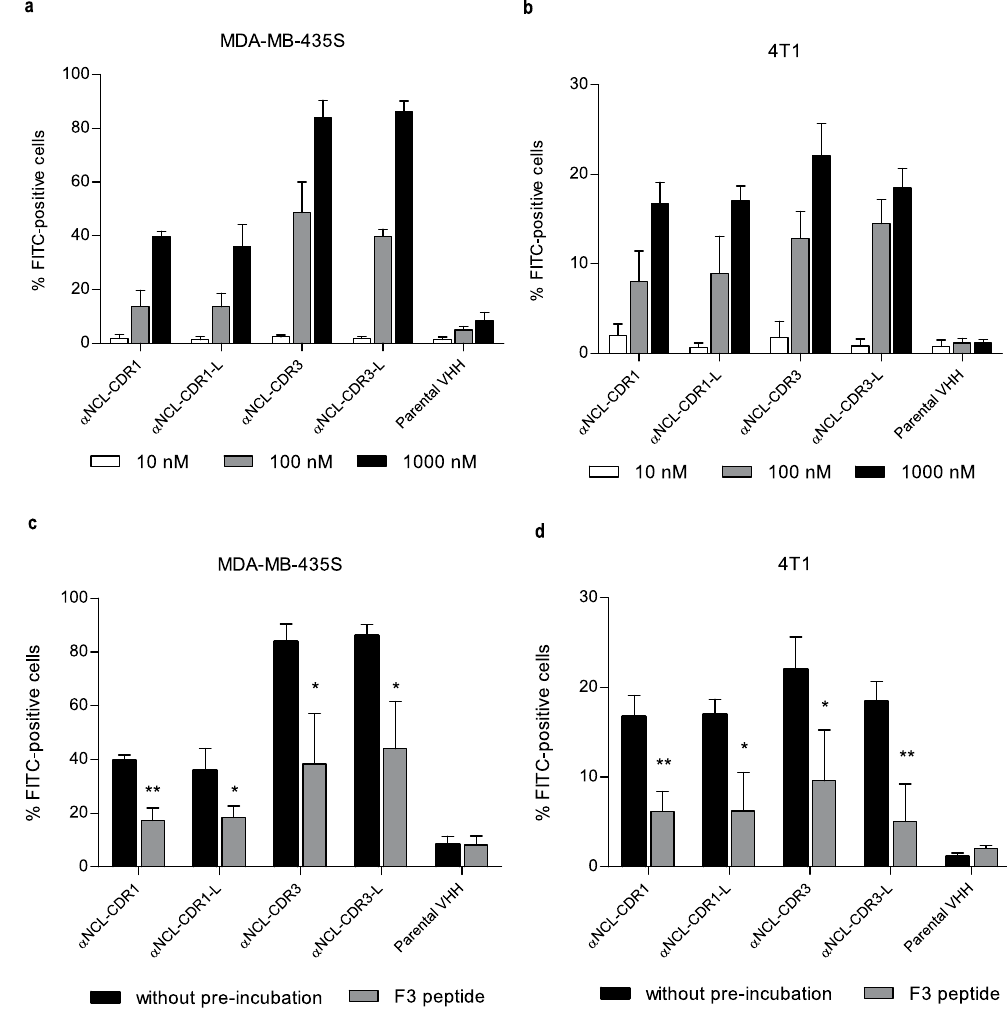
Figure 2. Binding of different VHH constructs to nucleolin-overexpressing cells. One hundred thousand of MDA-MB-435S ( a , c ) or 4T1 ( b , c ) cells were incubated with parental VHH or VHHs grafted with a nucleolin- binding peptide sequence either onto CDR1 or CDR3, with ( α NCL-CDR1-L or α NCL-CDR3-L, respectively) or without ( α NCL-CDR1 or α NCL-CDR3, respectively) flanking linkers at the end of the grafted CDR, for 45 min at 4 °C. Binding was assessed with a final incubation with anti-HA-FITC antibody and further analysis by flow cytometry. Competitive inhibition assays were also performed for each cell line ( c , d ), upon pre- incubation of the cells with 75 µ M F3 peptide (gray bars), for 30 min at 4 °C. A control without competitive inhibition was performed (black bars). Data represent the mean ± SD of three independent experiments, performed in duplicate. Differences in binding among the VHHs tested were evaluated by one-way ANOVA followed by Tukey’s test. Differences in binding, with or without pre-incubation with F3 peptide, were evaluated by Student’s t-test ( * p < 0.05, ** p < 0.01, *** p <